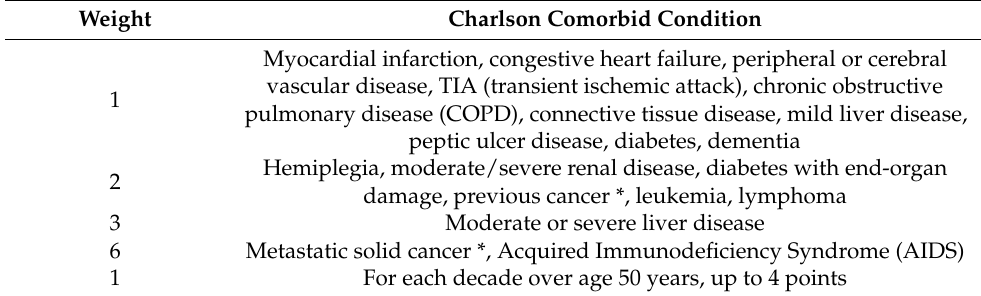
Table 1. Age-adjusted Charlson comorbidity index and comorbidity weighting.